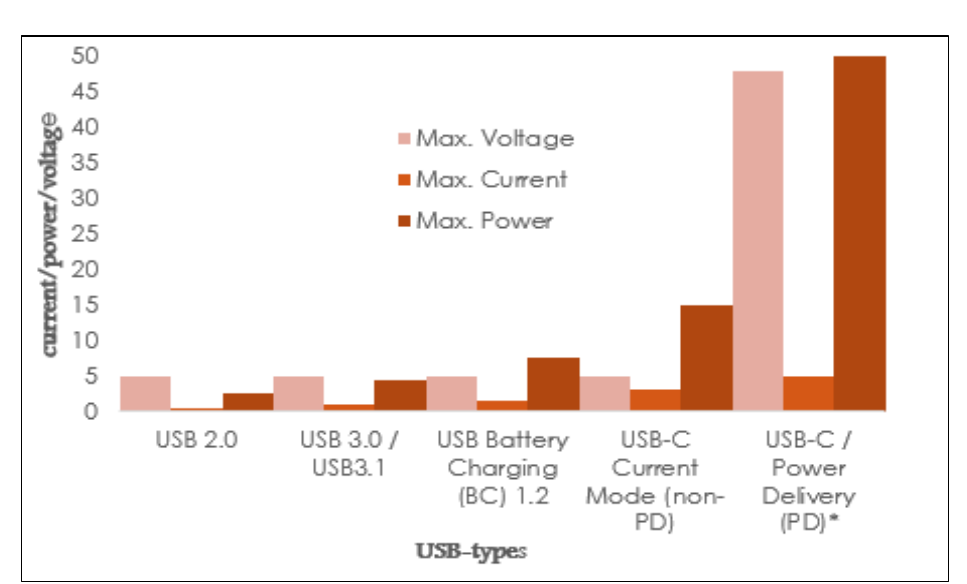
Figure 4: USB Characteristics.